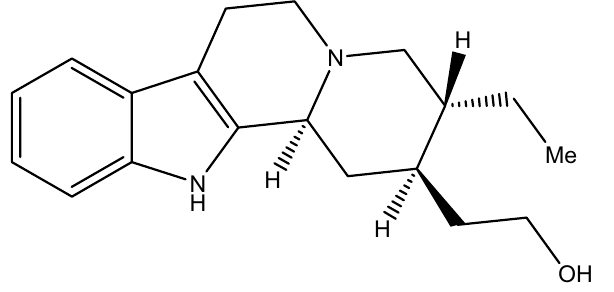
Figure 2. Structure and numbering system of SF8 subfraction (dihydrocorinantheol) based on its biogenesis.